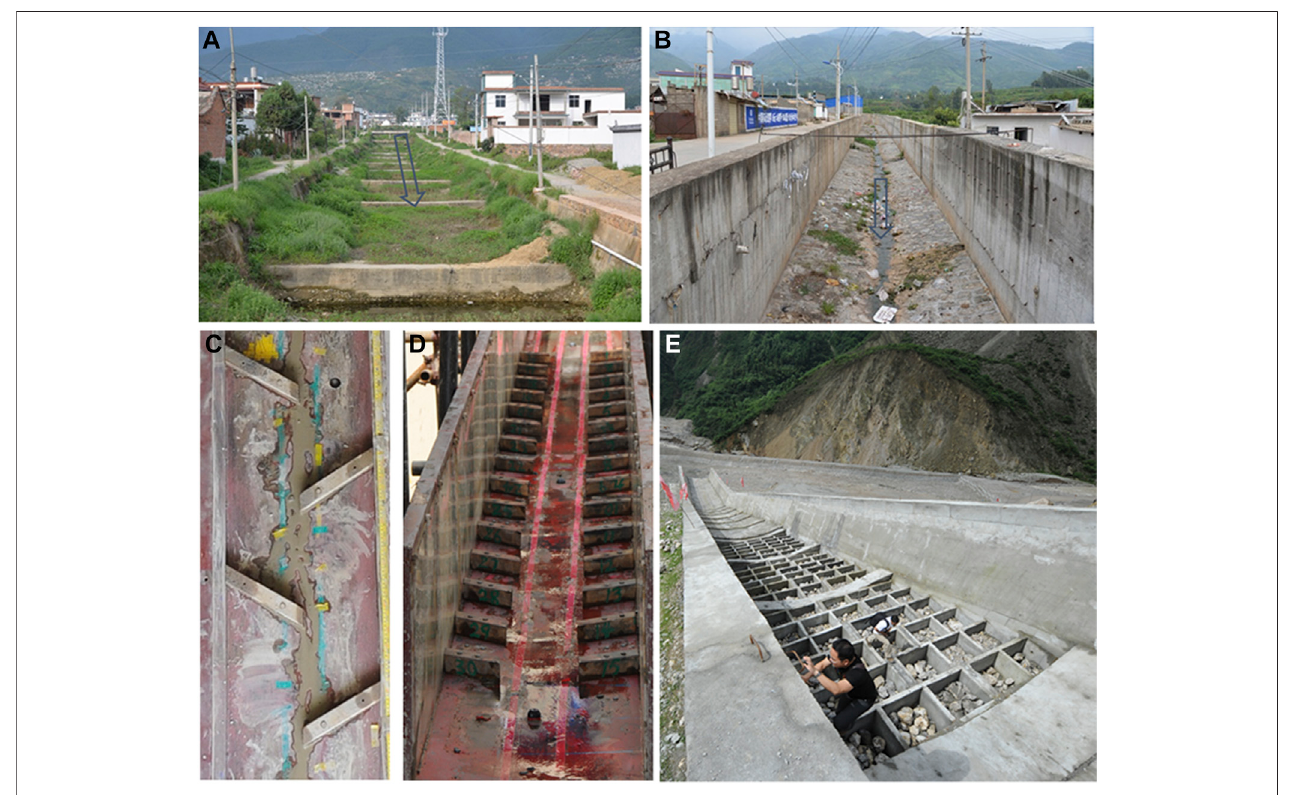
FIGURE 1 | Different types of debris fl ow drainage channels (A) Dongchuan-type; (B) V-type; (C) SIS-type; (D) OSS-type; (E) PRCB-type.